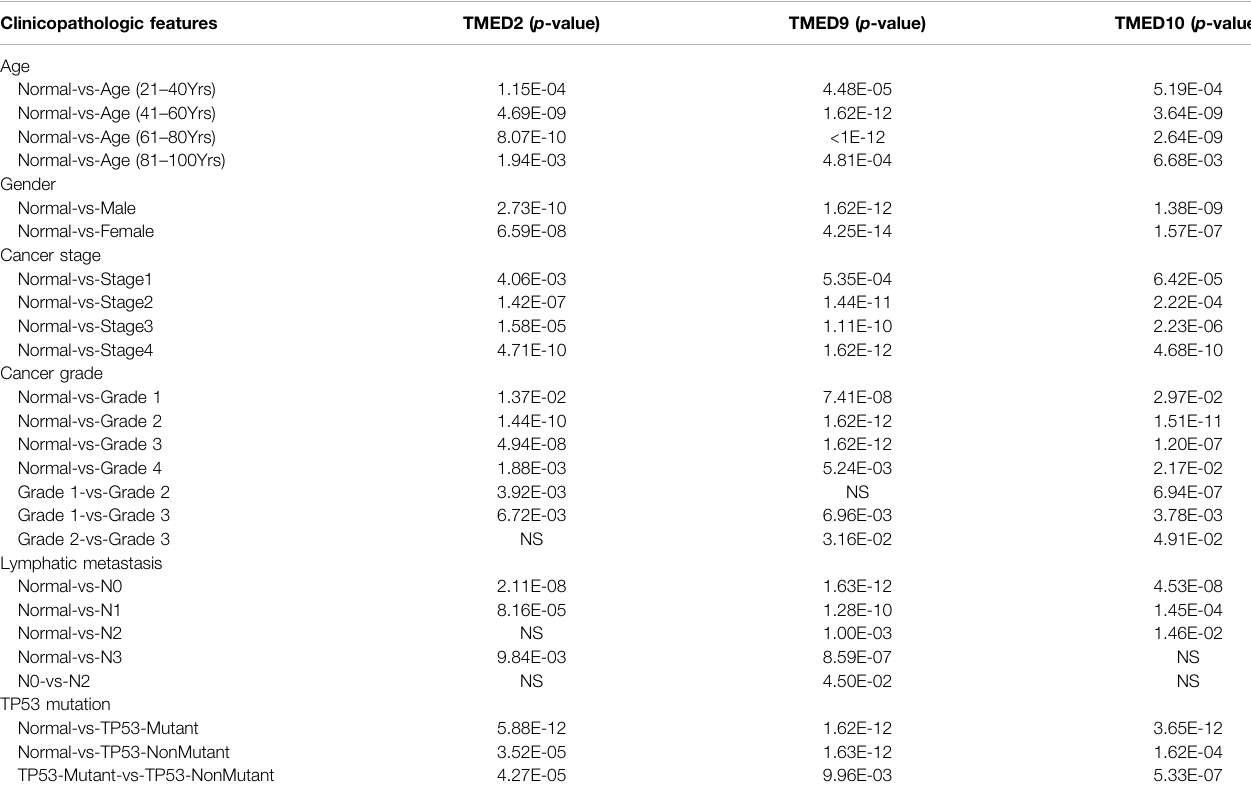
TABLE 2 | The relationships between TMED2/9/10 expression and clinicopathological features of HNSC patients in UALCAN. Clinicopathologic